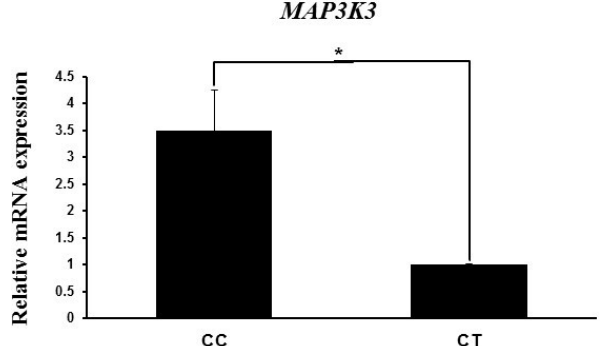
Figure 1. NAT9 mRNA expression in endometrial tissues according to genotype, as determined by RT-PCR. Peptidylprolyl isomerase A (PPIA) was used as an internal control. The fold change in mRNA expression level was calculated by comparing the mRNA expres- sion level in the genotype with the lowest expression with that of the other groups. Data represent mean ± SD.